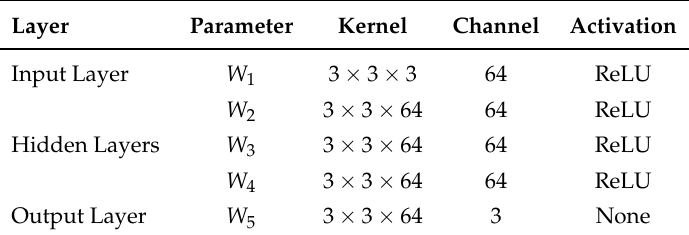
Table 1. The architecture of the OCC